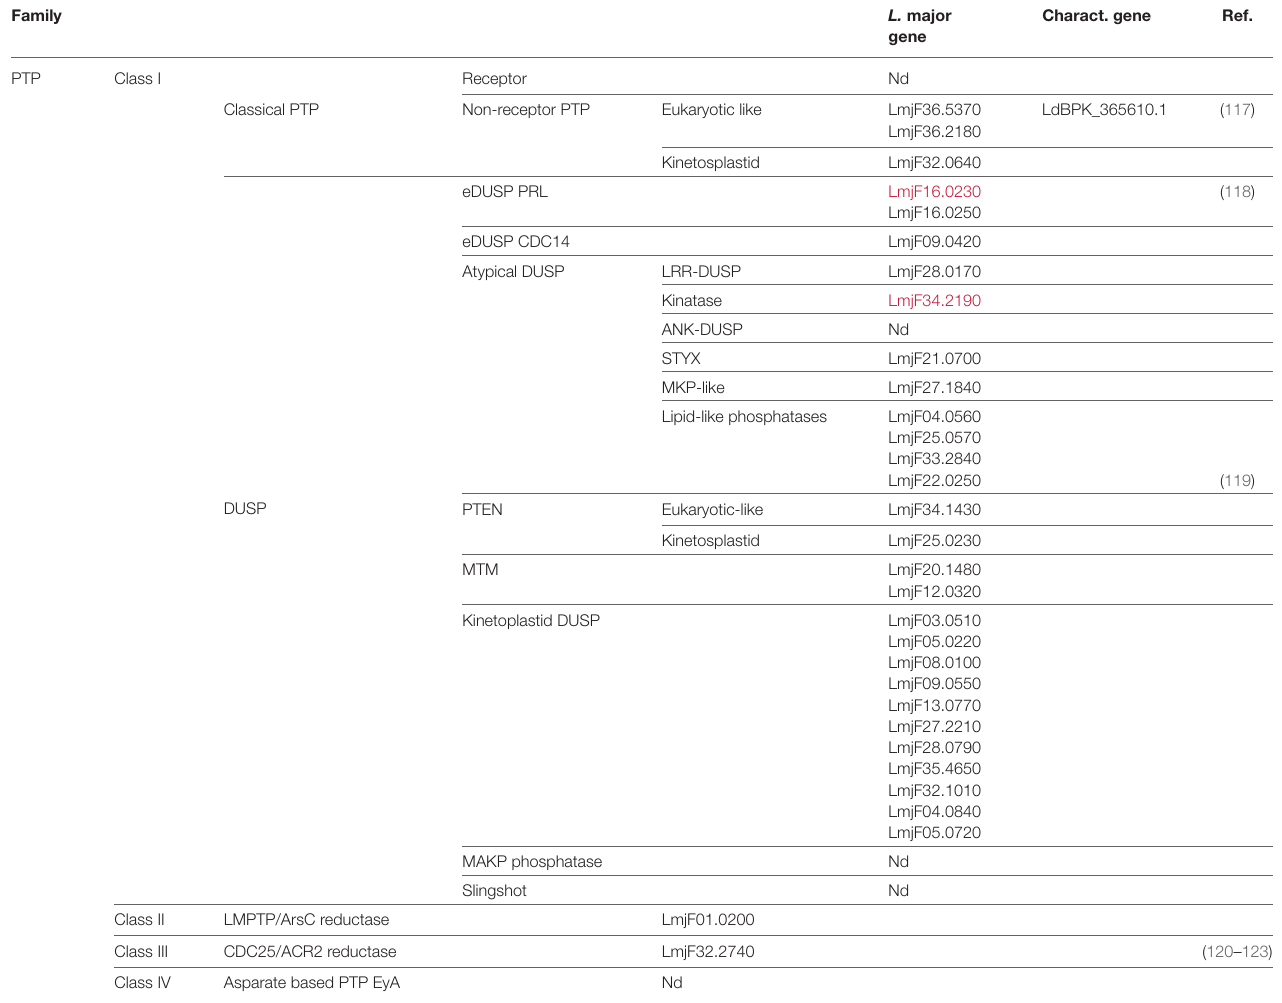
TABLe 2 | Tyrosine phosphatases of Leishmania major. a